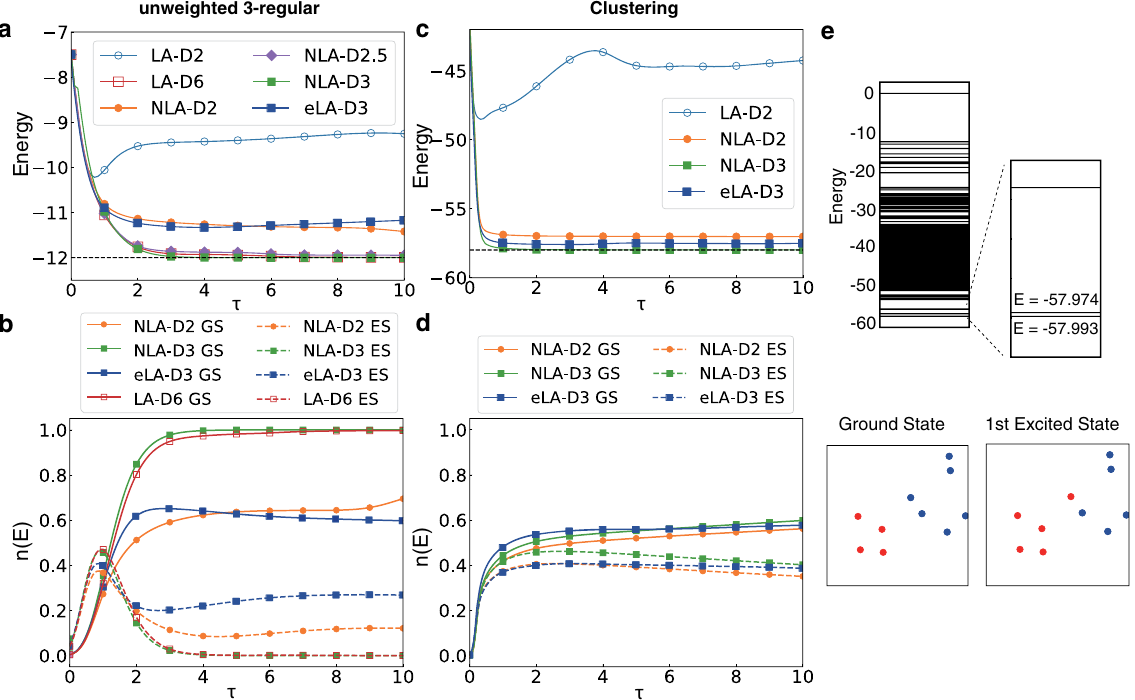
Fig. 2 Numerical simulation of QITE method. Energy E ( a ) and component proportions of the state n ( E ) ( b ) in the QITE method to the max- cut problem for an unweighted 3-regular graph with ten vertices. The ground state is denoted by GS and the fi rst excited state by ES. The energy E ( c ) and component proportions n ( E ) ( d ) of the QITE method for a weighted fully connected graph with ten vertices. e The total energy level diagram of the weighted fully connected graph and the eigenstates corresponding to the ground state and the fi rst excited state (divided into two regions, red and